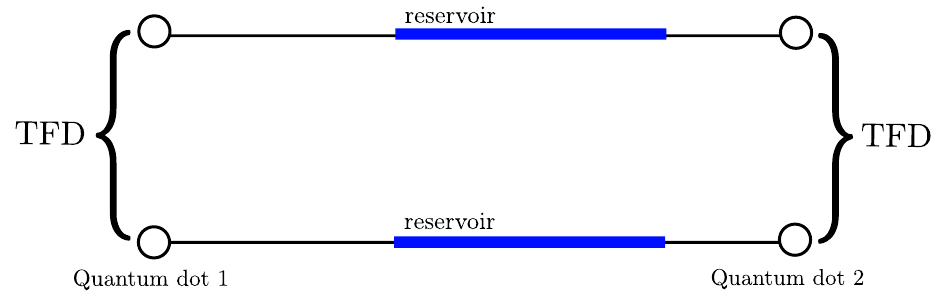
Figure 12. We consider the radiation in the bold blue segments of the